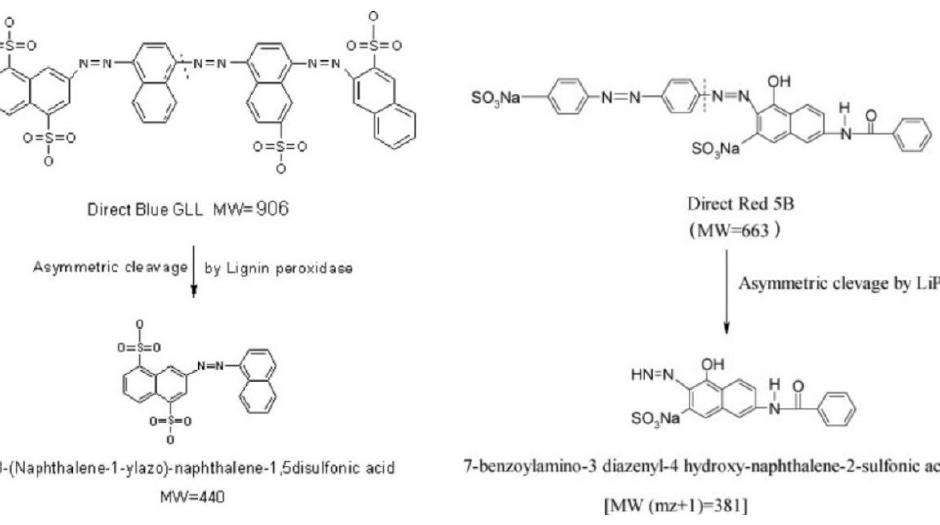
Figure 5. Reaction mechanism of LiP in a degradation pathway of azo dyes.